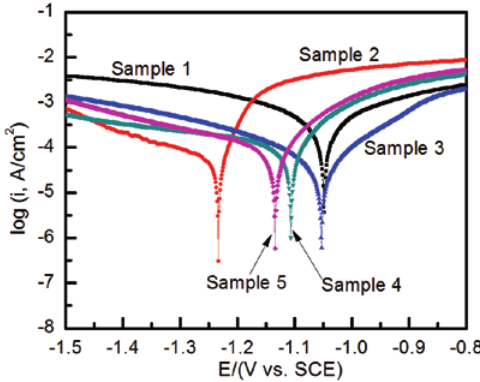
Figure 5: Polarization curves of the samples after aging for 10 h at 175 °